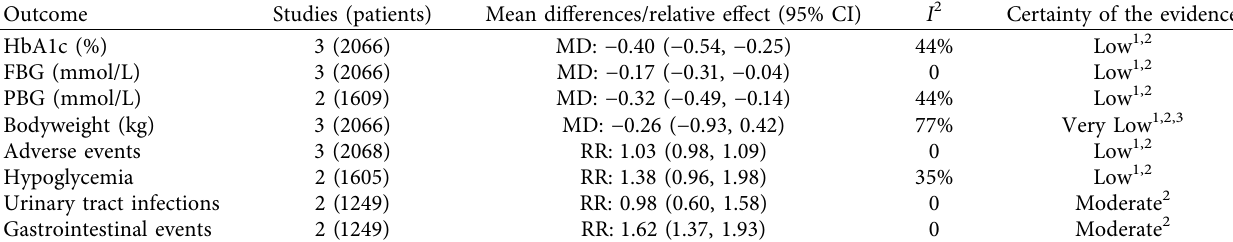
Table 2: Summary of findings and strength of evidence.